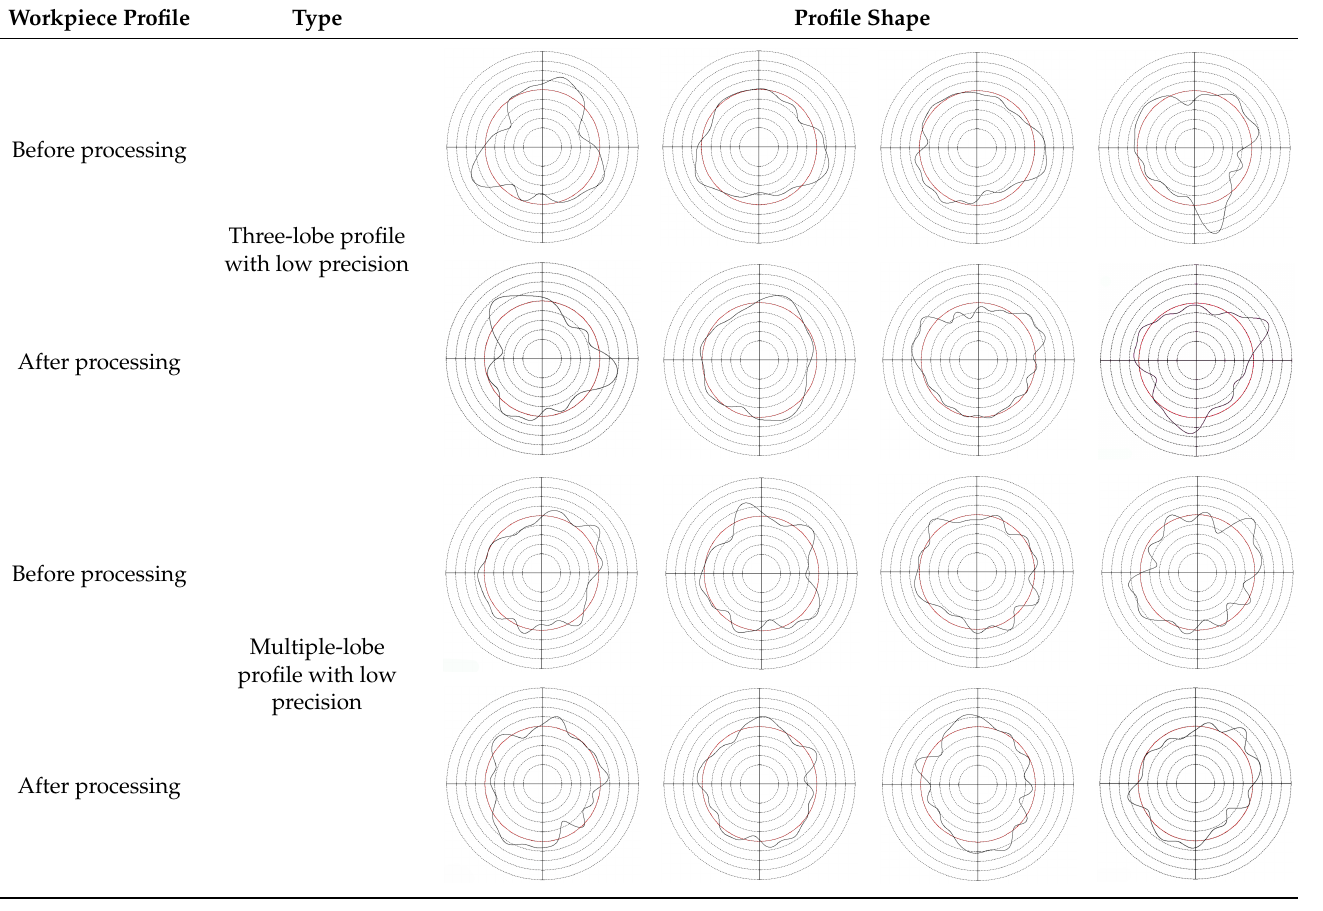
Figure 10. Error correction under different profile shapes: ( a ) multiple-lobe profile; ( b ) three-lobe profile. Table 12. Profile shape before and after processing under 30° cathode coverage.